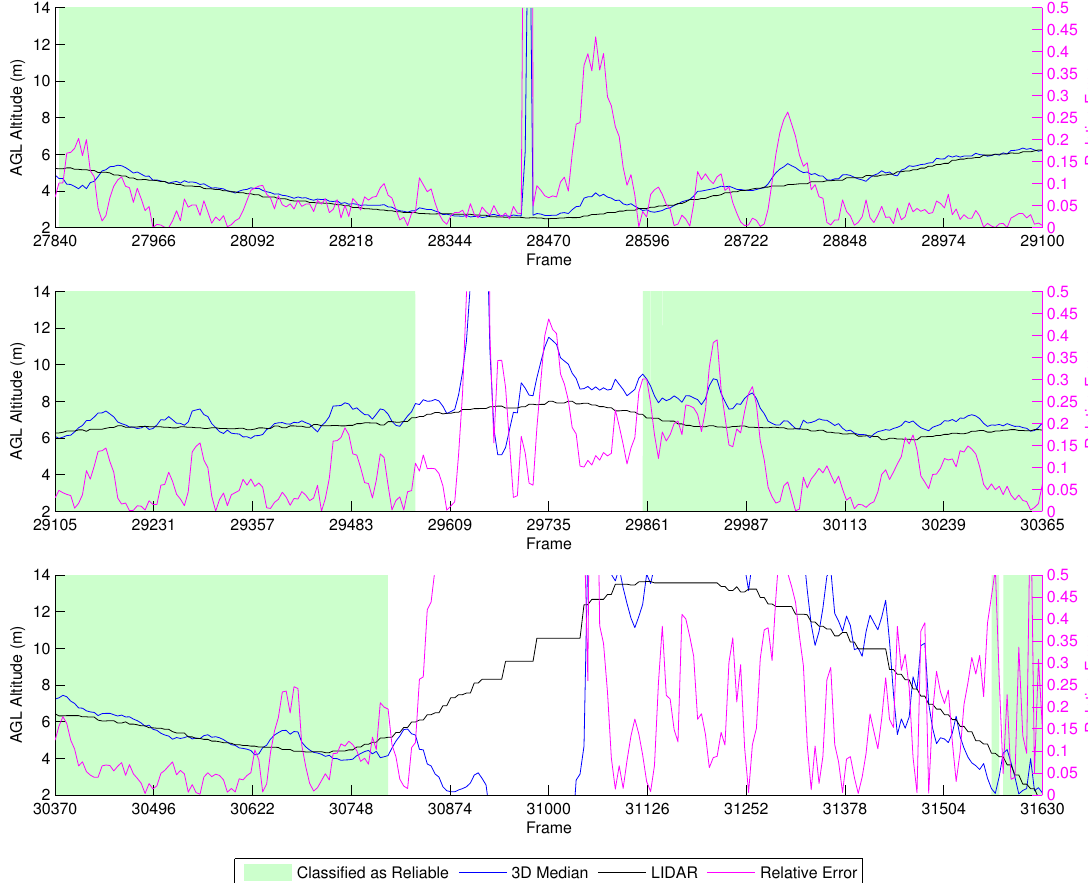
Figure 16. Height estimation results for the LIDAR experiment at a fixed ASL